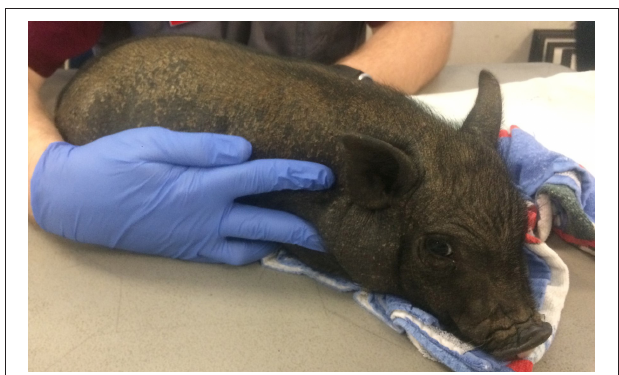
FIGURE 4 | Photographs from recheck examination. Note the hair regrowth, increased dorsal scaling and resolution of the previously examined